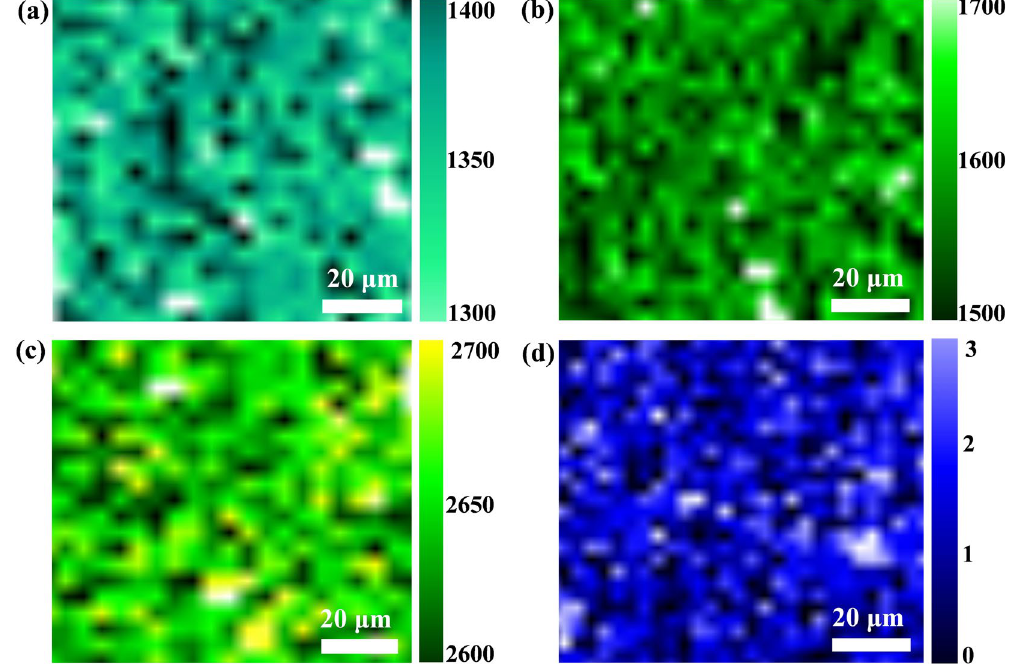
Figure 4. Raman mappings of graphene/h-BN heterostructures: Raman mappings of ( a ) h-BN peak; ( b ) G peak; ( c ) 2D peak; ( d ) I 2D /I G